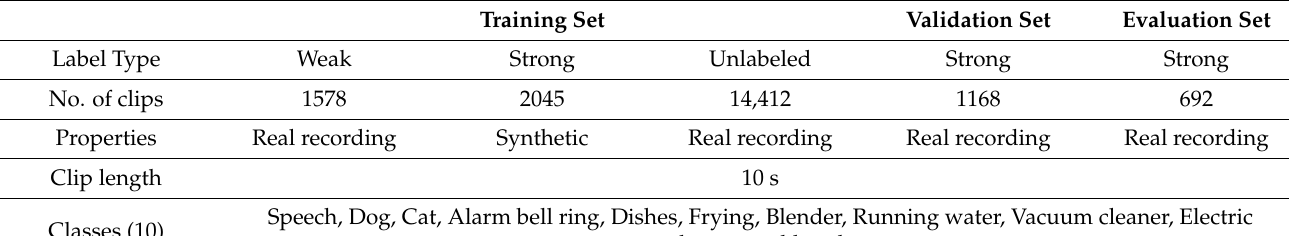
Table 1. Dataset used in the